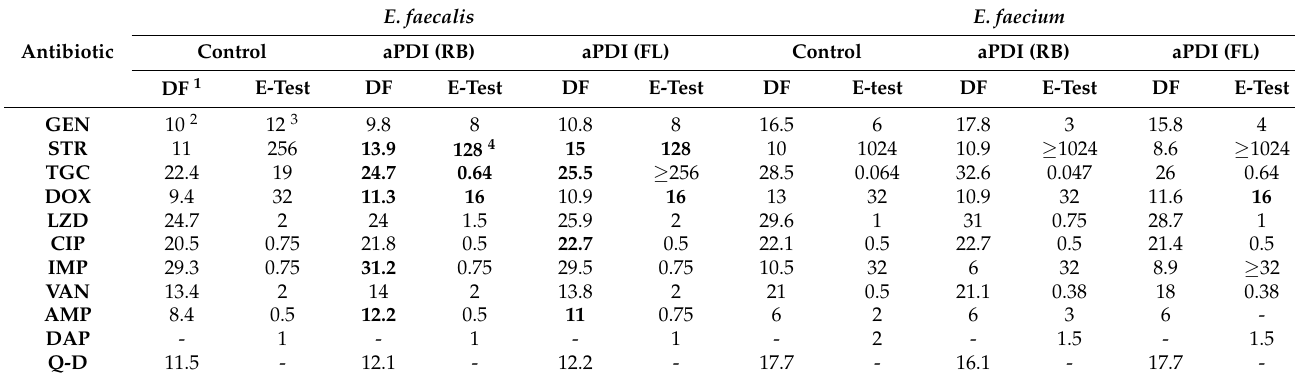
Table 2. Antimicrobials MIC change upon sublethal aPDI treatments.